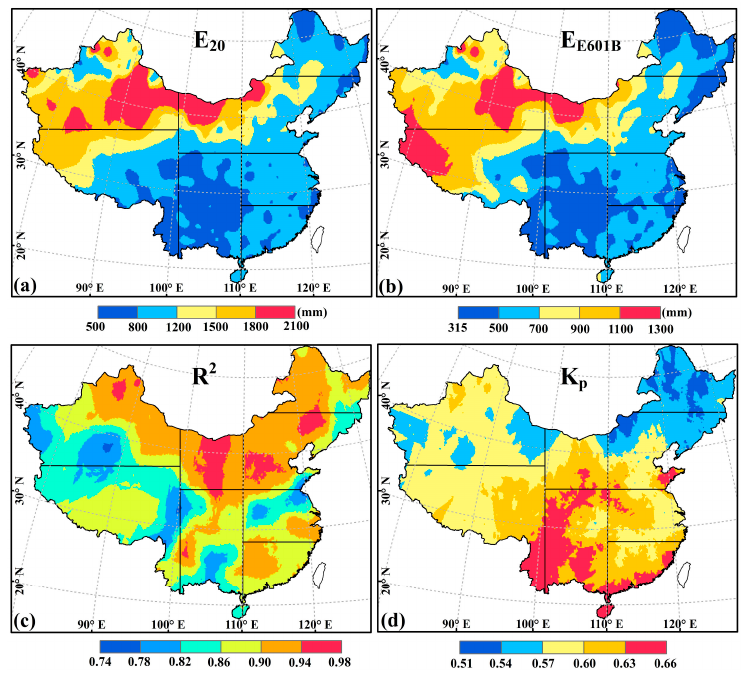
Figure 3. Spatial distributions of φ 20 ( a ) and E601B ( b ) evaporation; the determination coefficient R 2 ( c ); and the conversion coefficient K p ( d ) between the two pan evaporations during the warm season